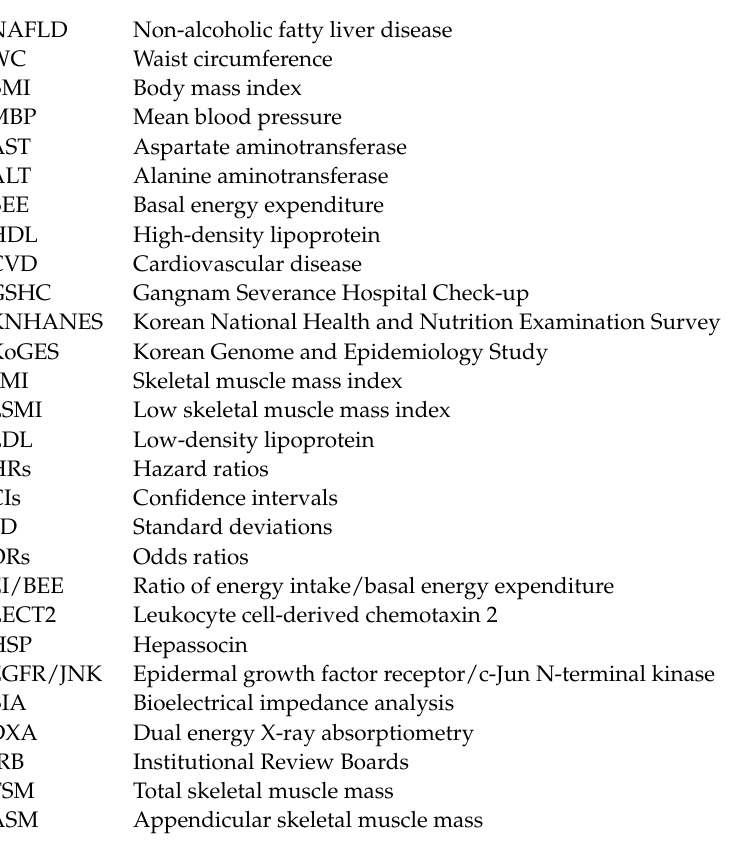
status, Figure S2. Kaplan-Meier curves for incident NAFLD according to LSMI